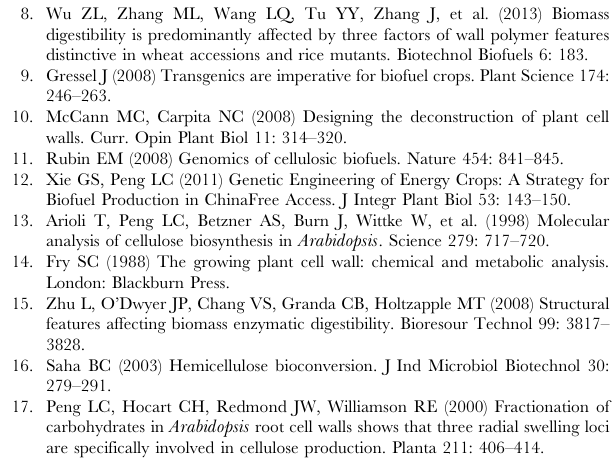
Table S1 Variations of wall polymers and biomass digestibility in total 40 corn accessions.